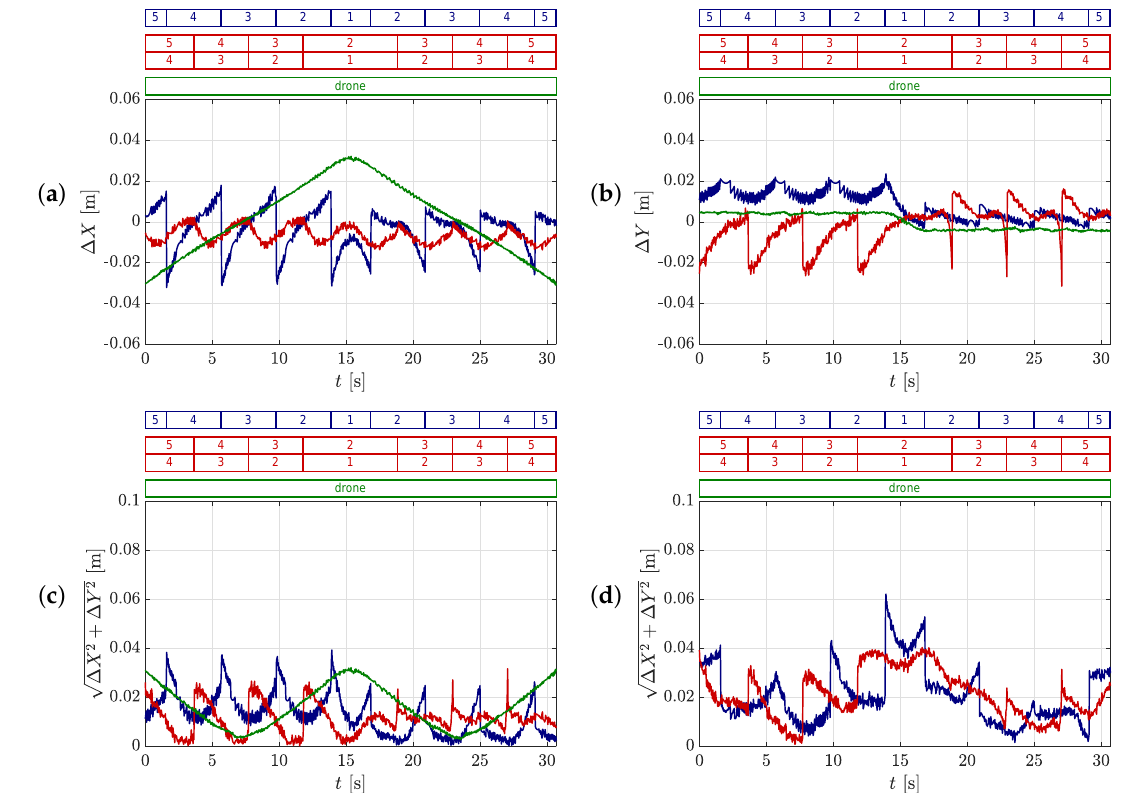
Figure 25. Overview of the systematic error induced by the projection of the hemisphere-shaped pedestrian’s hat for the mono-vision static camera setup (blue), stereo vision static camera setup (red) and mono-vision drone camera setup (green): ( a ) longitudinal and ( b ) lateral error relative to the true trajectory, ( c ) absolute error relative to the true trajectory and ( d ) absolute difference of the trajectory obtained by the static camera setup relative to the drone camera